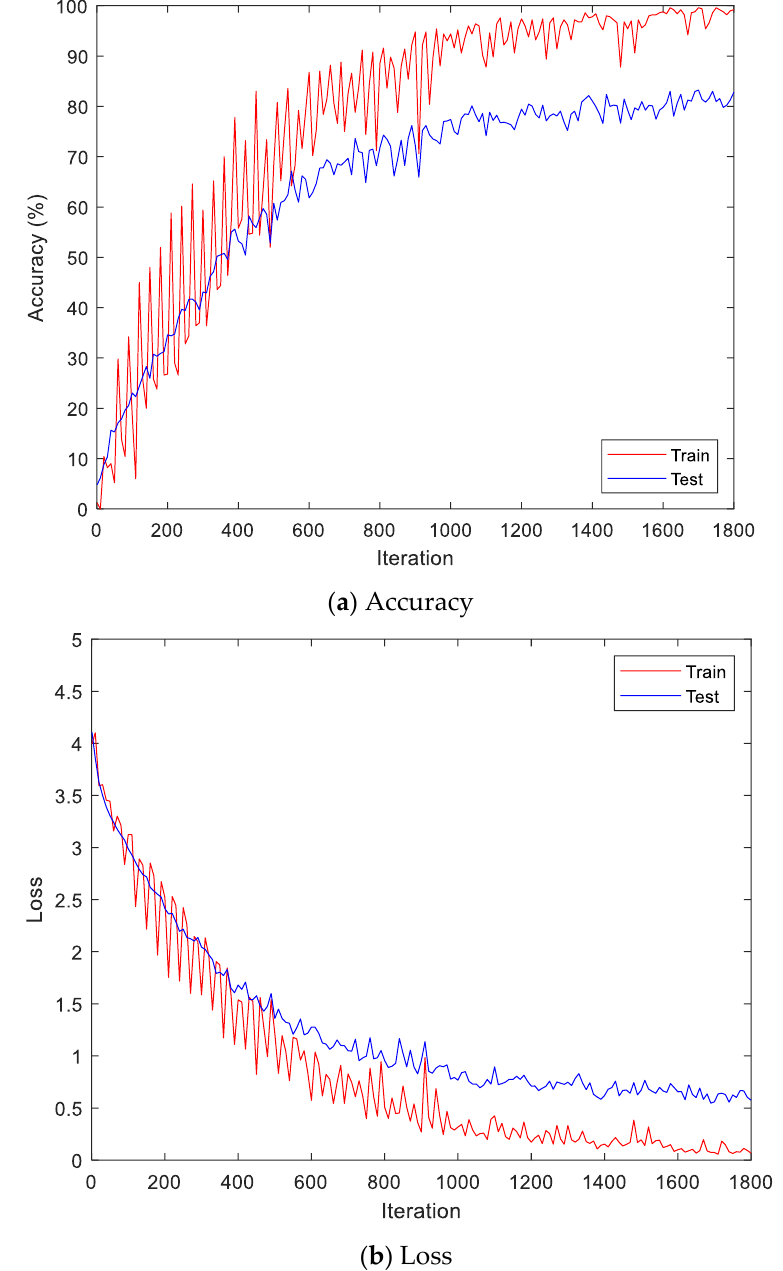
Figure 9. Training process by the scalogram and CNN-based individual identification model (An- geles EMG dataset).